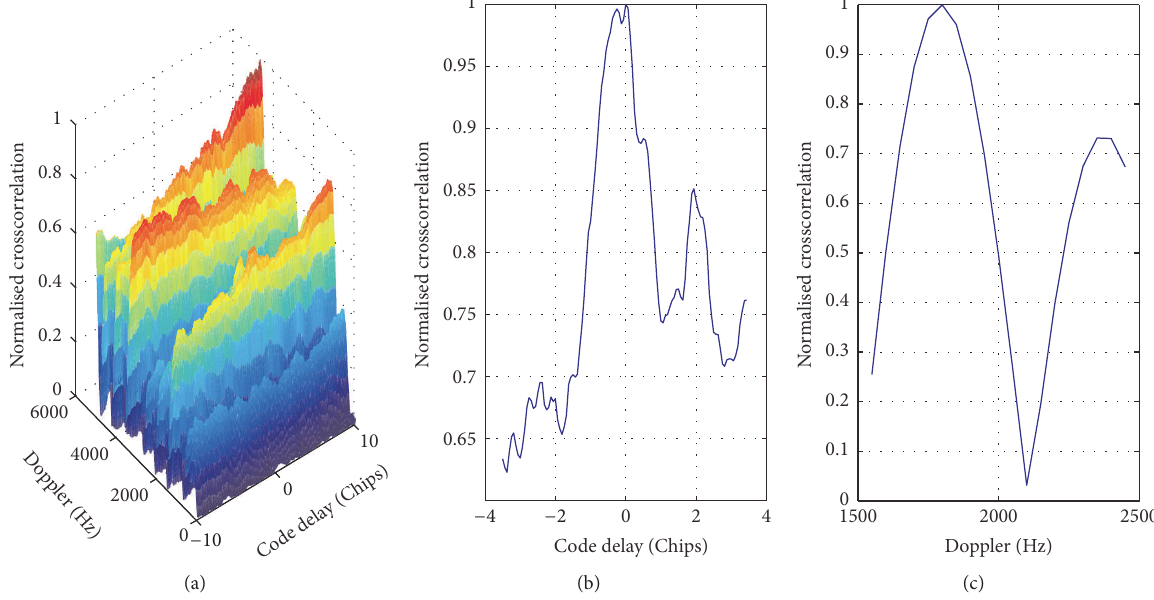
Figure 11: Correlation peaks after interference suppression by S-MPDR beamformer for scenario